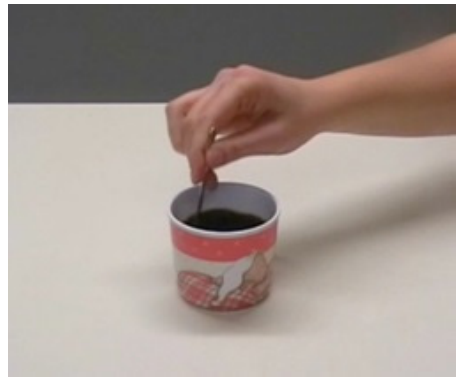
Figure 1. The “stirring” picture stimulus is displayed which was taken as a screenshot from the original stirring stimulus